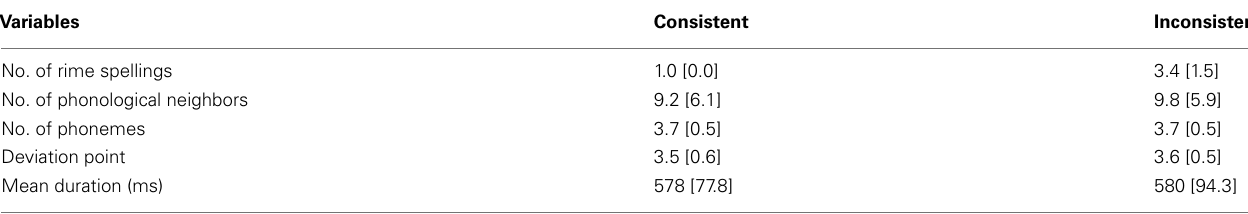
TableA4 | Characteristics of the pseudoword